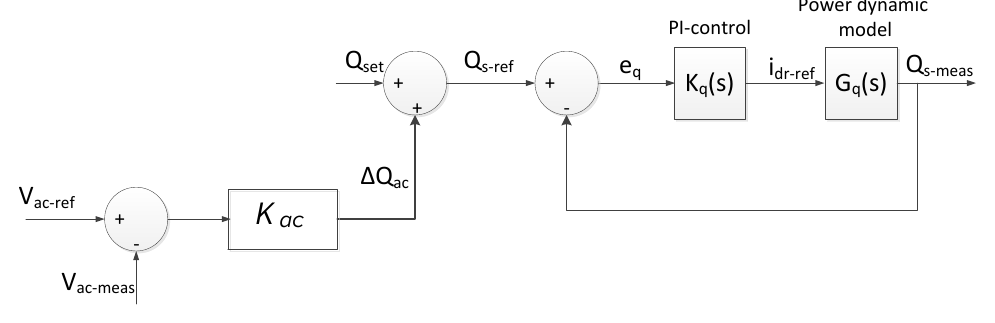
Figure 8. A rotor-side converter of reactive power control structure.